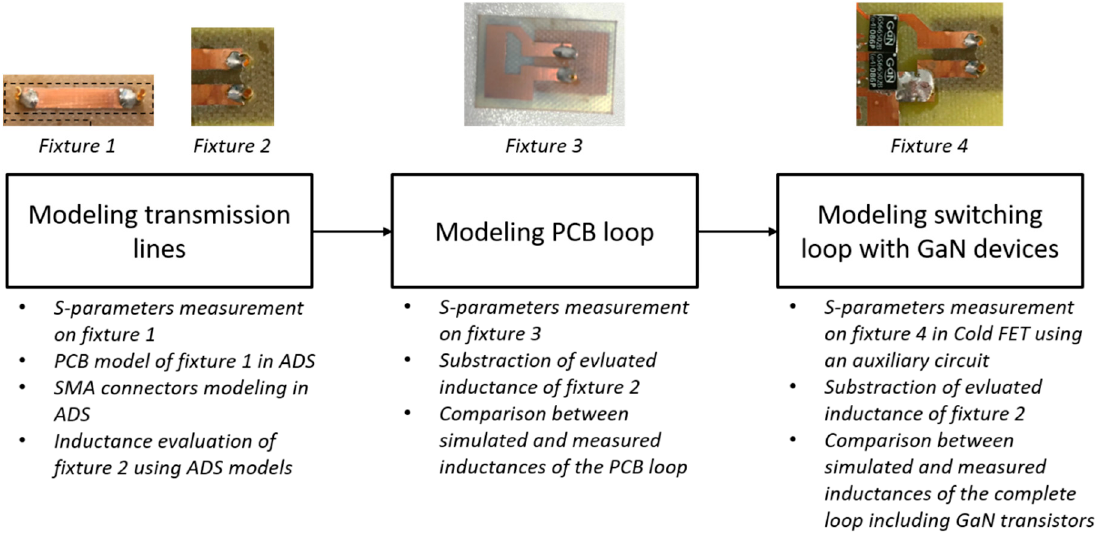
Figure 3. Organizational chart of the proposed modeling method.